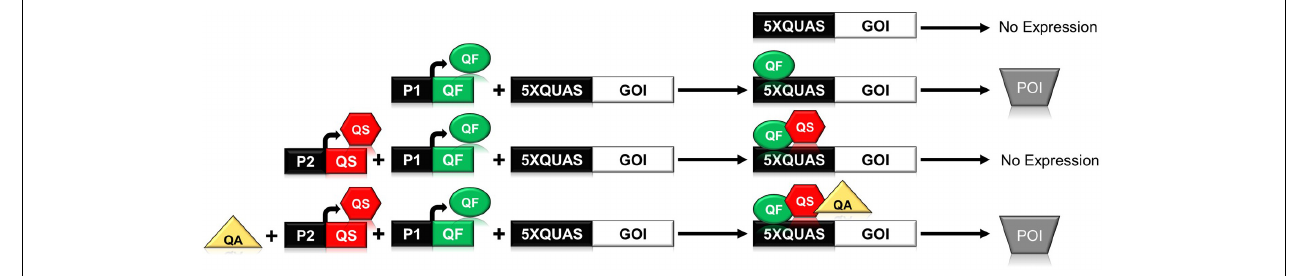
FIGURE 1 | Schematic illustrating the function of the components of the Neurospora crassa Q-system. The Q-system is a multi-component system composed of a transcriptional activator (QF), repressor (QS), and a small molecule inducer, quinic acid (QA), that removes the effect of the repressor. As shown above, binding of QF to the QUAS promoter sequence results in expression of the gene of interest (GOI) leading to production of the protein of interest (POI). If QS is expressed in concert with QF, then QF is repressed and no gene expression is observed. If all three components, QF, QS, and QA are present, then the system is once again